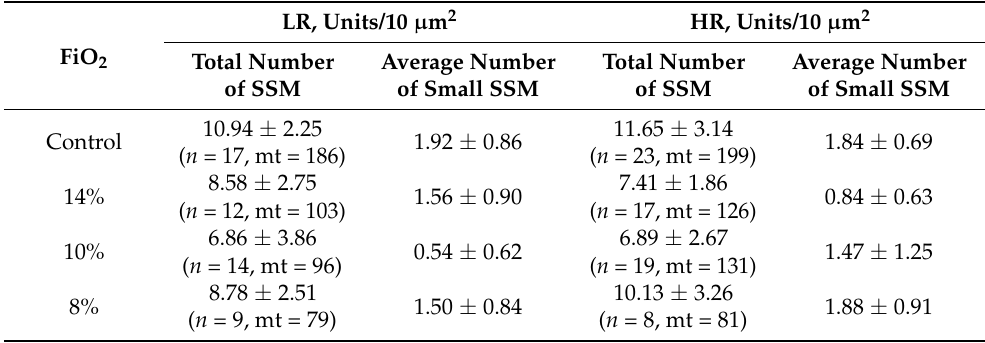
Table 4. Morphometric characteristics of SSM in the myocardium of HR and LR rats after a single exposure to different HBH regimens.